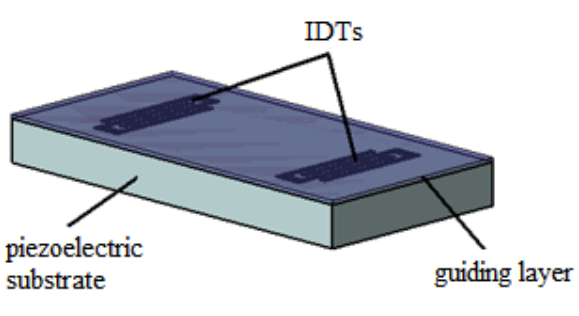
Figure 15. Scheme of a LW